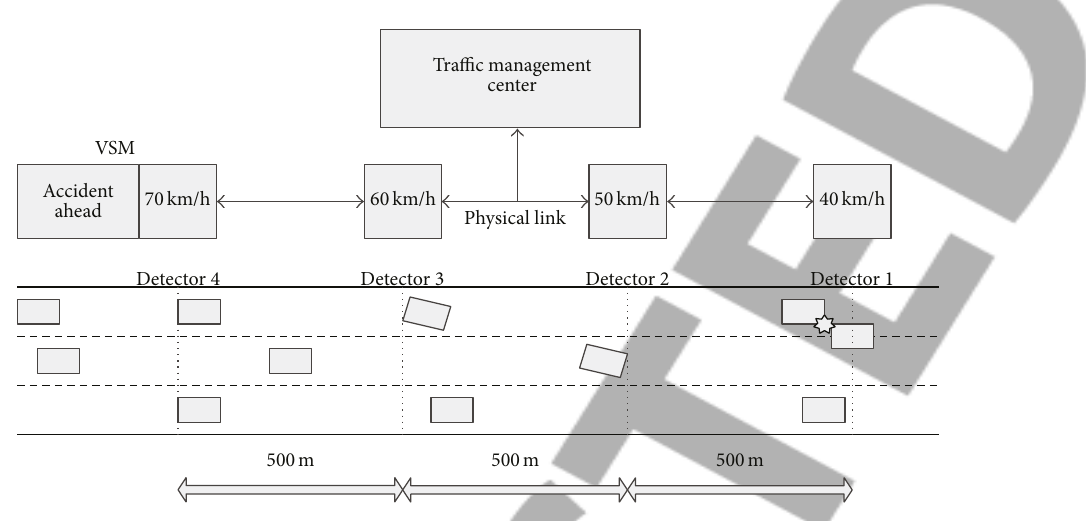
Figure 1: Fundamental layout of the VSL